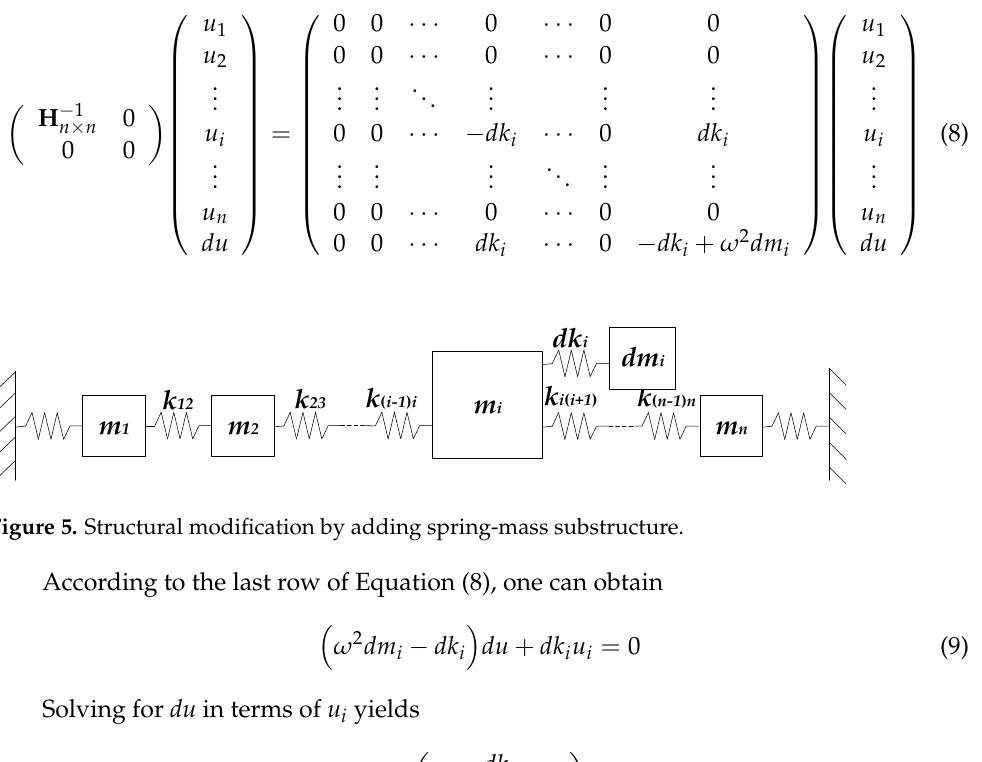
addition of this spring-mass substructure, an extra DOF was introduced. Consequently, the matrices in Equation (4) were enlarged by one row and column, as shown in Equation (8).